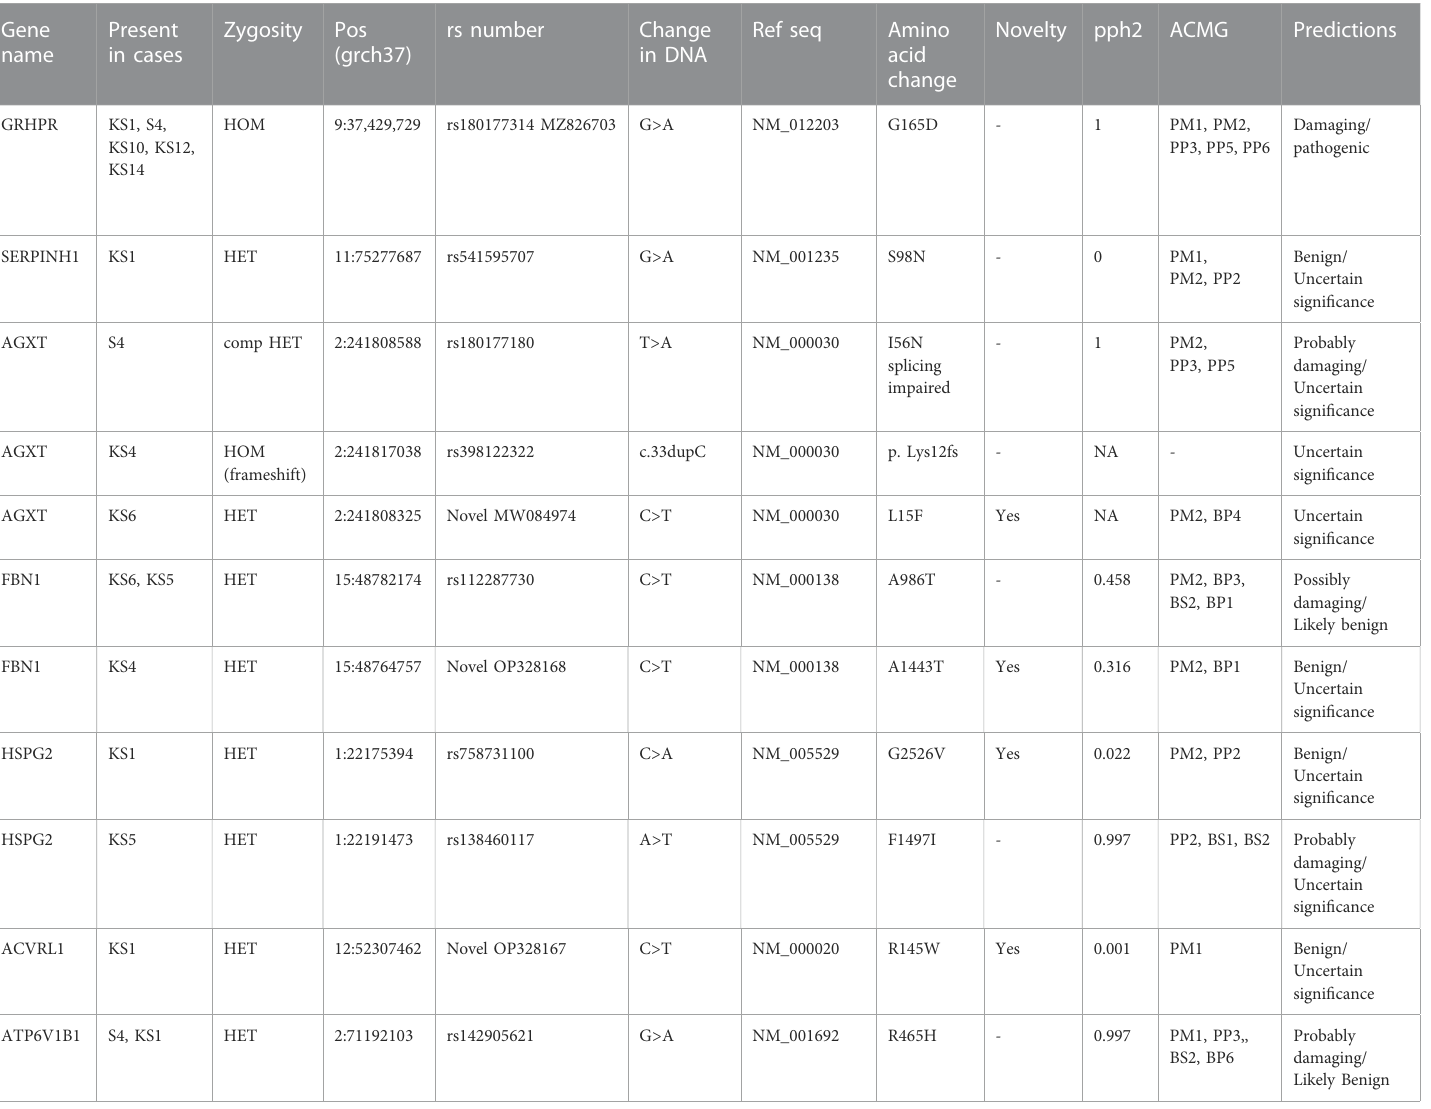
TABLE 2 Mutation detected in all the pediatric samples with KSD or NL. Sl.